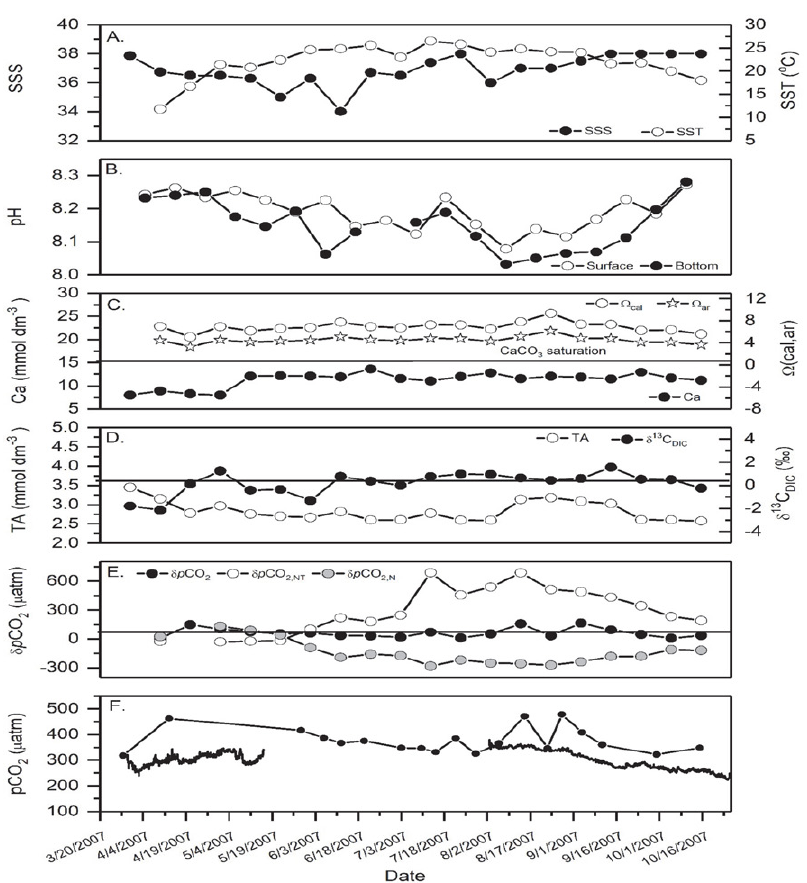
»termični« (δ p CO 2,T ) in »netermični« (δ p CO 2,NT ) vplivi na morski p CO2 v južnem delu Tržaškega zaliva (E) in p CO 2 (F) • – iz TA in pH, 16 – in situ v globini 3 m. 22 Razlike med izračunanimi in merjenimi in situ p CO 2 pripisujemo predvsem izbiri disociacijskih konstant ogljikove kisline v morski vodi, vpliv raztopljenih organskih baz (ang. Dissolved Organic Carbon – DOC) pa je majhen.